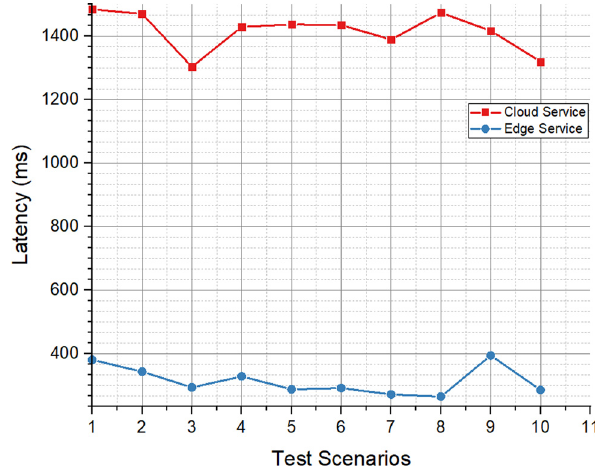
Figure 8: Average latency with 10 test scenarios.